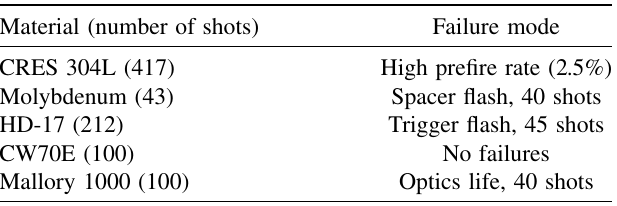
TABLE III. Switch failure modes directly attributable to trig- ger electrode material. All data were for switches operated at 5.4 MV, peak current of 700 kA, with 1 C total charge conducted per